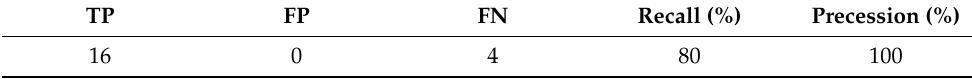
Table 6. The performance criteria of detecting the KolektorSDD